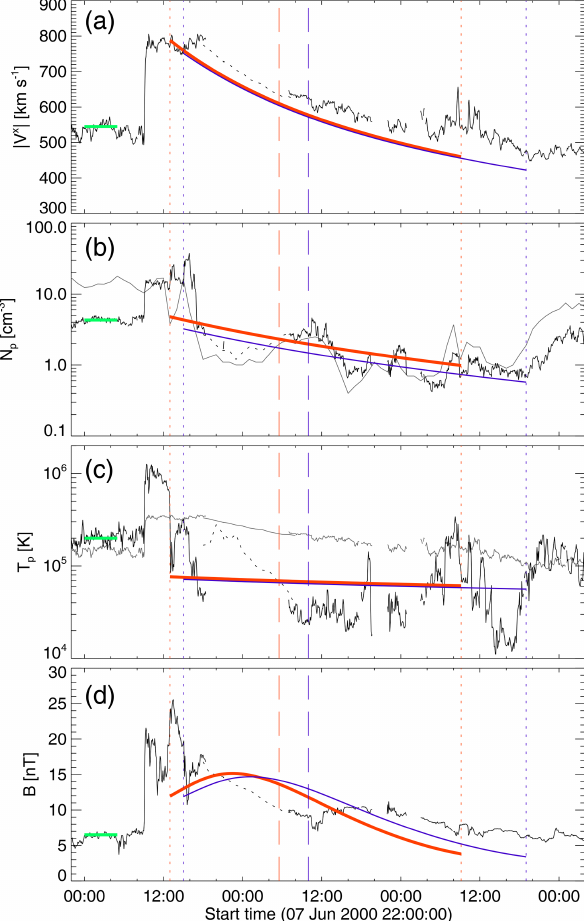
Figure 10. Synthetic transit profiles of Event 1 calculated for dif- ferent values of free parameters. Panels (a) , (b) , (c) , and (d) present the radial component of the solar wind speed ( | V x | ), the density ( N p ) and temperature ( T p ) of protons and the magnetic field inten- sity ( B ), respectively. The red profiles were calculated with values of free parameters fixed by Eqs. (18) to (21), and the blue profiles are the same as shown in Fig. 4. Short-dashed and long-dashed ver- tical red lines mark the CME boundaries and center, respectively. Solid (dotted) black lines are 5min (1h) in situ measurements as extracted from NASA/GSFC’s OMNI data set through the OMNI- Web service. Green solid lines mark in situ solar wind used for cal- culations (see Table 1). Solid grey lines in N p and T p panels are the plasma beta (10-fold) and the expected proton temperature ( T exp ) (Lopez, 1987; Richardson and Cane, 1993, 1995), respectively. The free parameter values used to calculate the red synthetic transit were c = 18 . 29, k = 2 . 56, T ∗ = 2 . 16, and b = 23 .